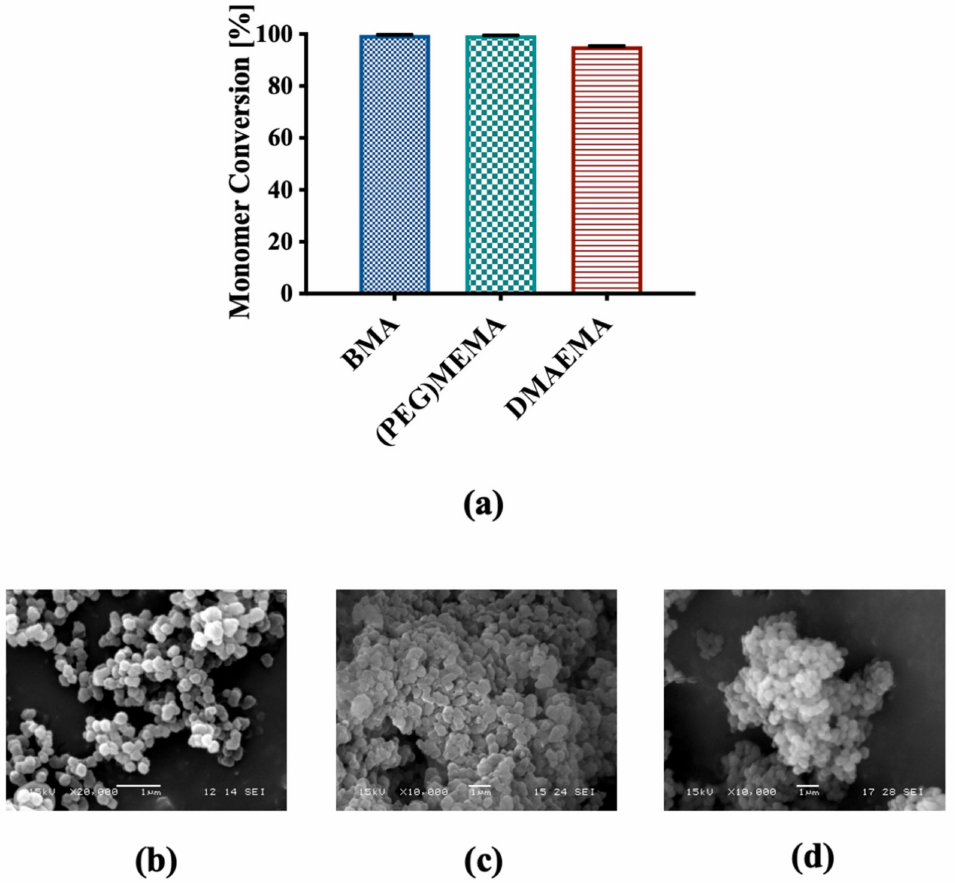
Figure 2. ( a ) Percentage conversion for each monomeric unit; SEM representative micrographs of ( b ) PMMA sacrificial core, ( c ) NCs before and ( d ) after extraction of the